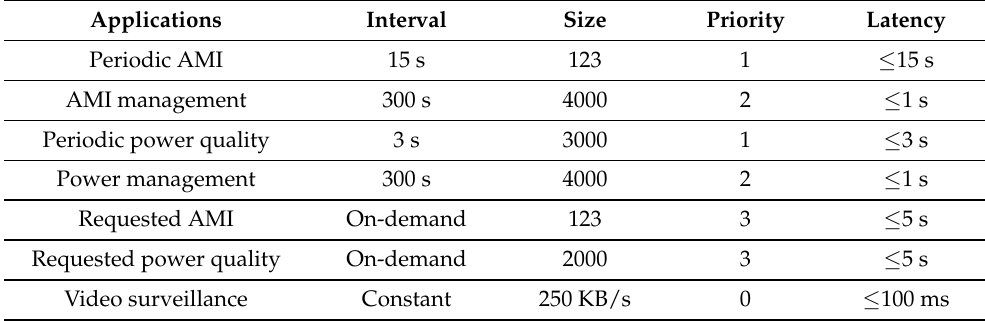
Figure 4. The topology of the SDN network (with 10 nodes) generated by mininet during simulation. Table 3 randomly. Table 3. Smart grid applications